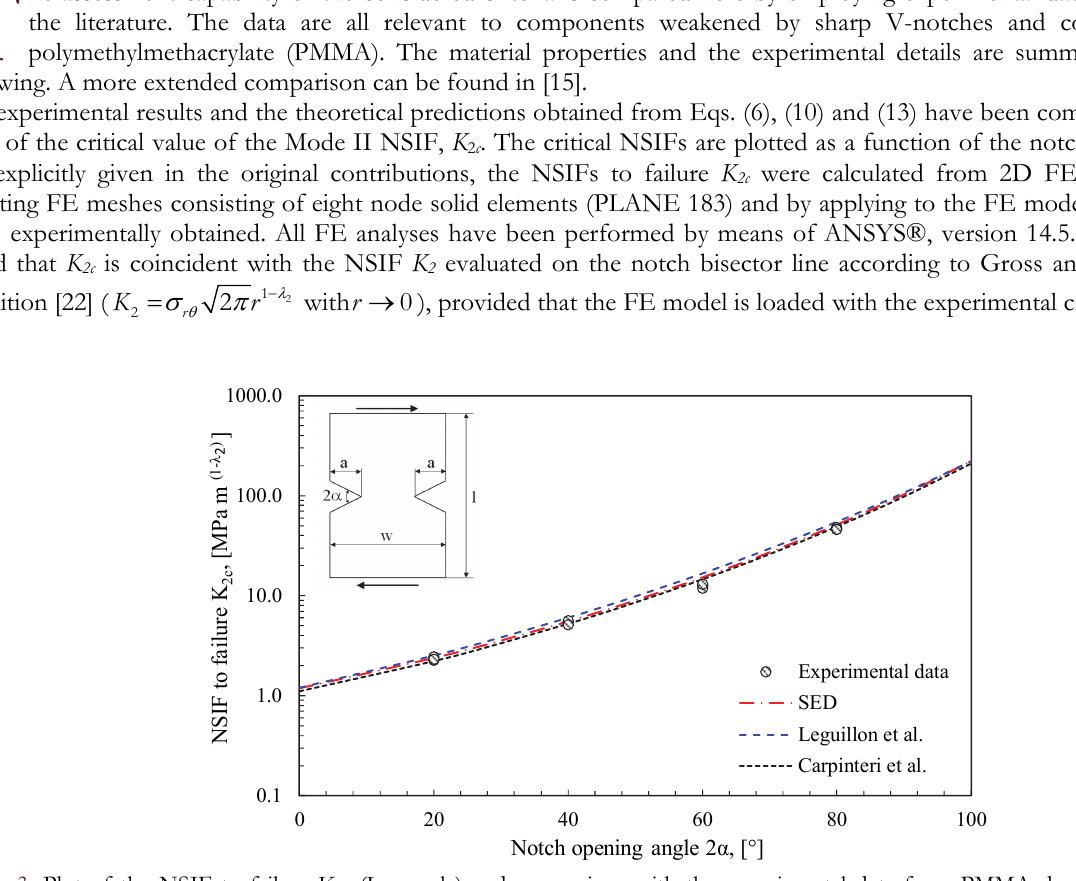
Figure 3: Plot of the NSIF to failure K 2c (Log-scale) and comparison with the experimental data from PMMA double V-notched